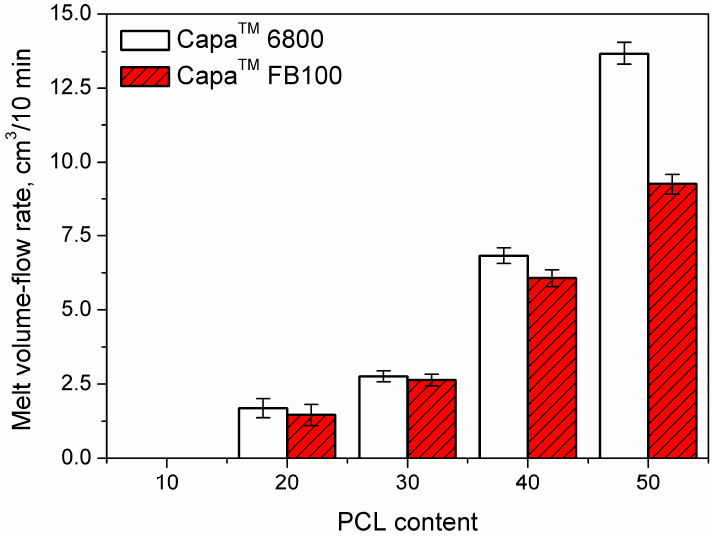
Figure 1. Melt volume flow rate for the studied reclaimed rubber/poly( ε -caprolactone) (RR/PCL) blends.